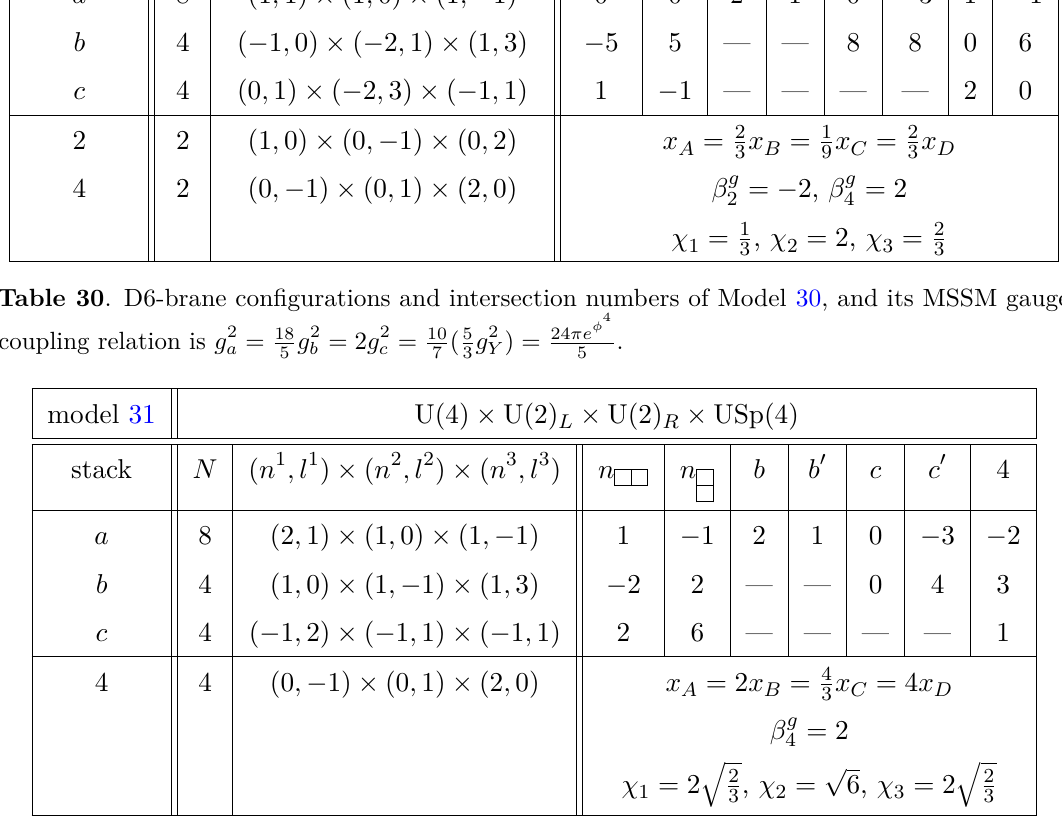
Table 31 . D6-brane configurations and intersection numbers of Model 31, and its MSSM gauge